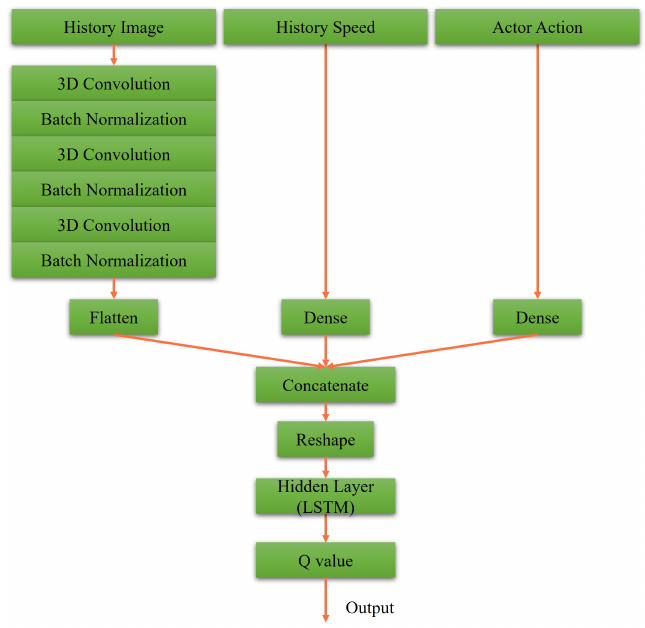
Figure 10. Our critic network for